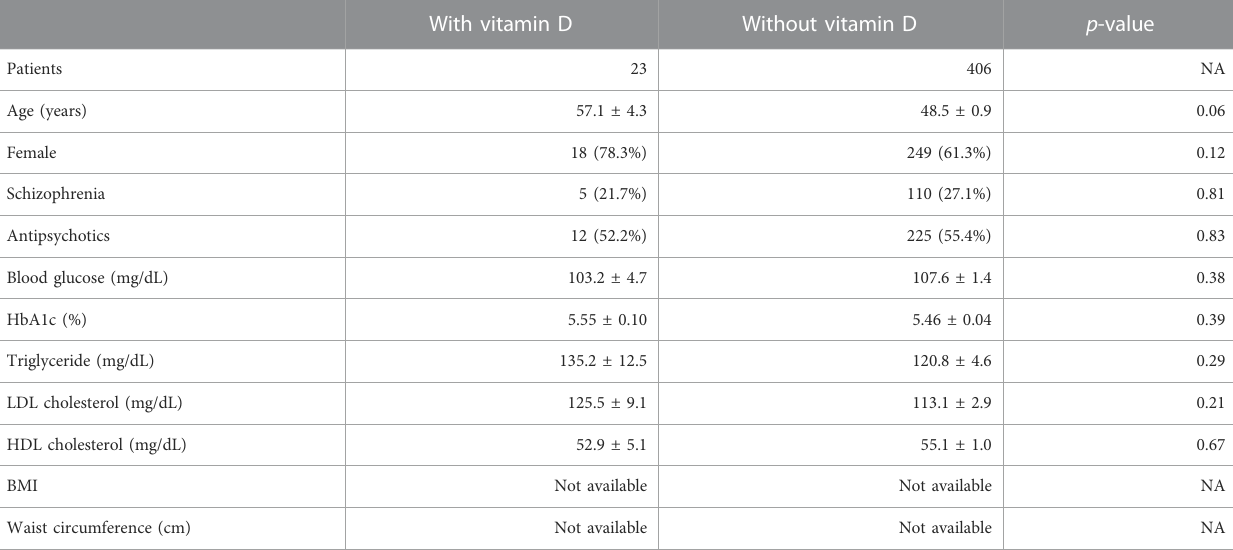
TABLE 3 Population characteristics of the patients in the olanzapine cohort of the NUSM ’ s CDW database; quanti fi able data are given as means ± SEM. With vitamin D Without vitamin D p